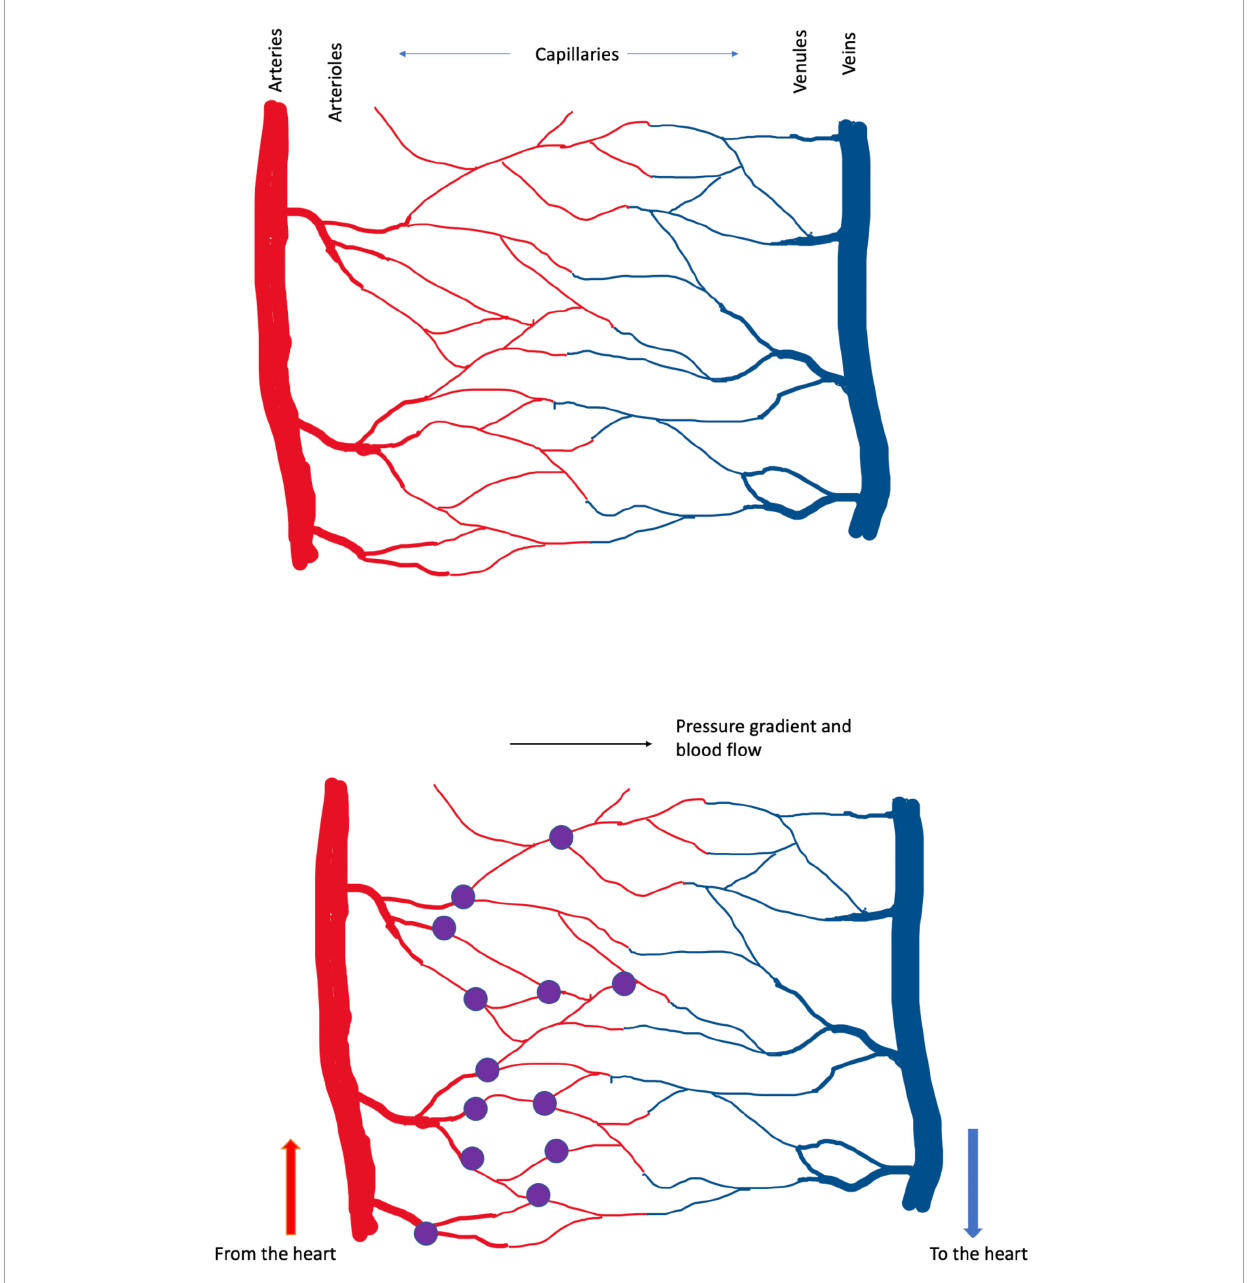
FIGURE2 (Upper) Schema of cerebral blood vessels. Blood enters the brain, and other tissues, at high, pulsatile pressure, along arteries. It is distributed by smaller arteries and arterioles, which break up into capillaries, from which oxygen diffuses into the tissue. Deoxygenated blood drains from capillaries into venules and veins, which return blood to the heart and lungs, for reoxygenation and recirculation. In these diagrams high pressure is in the arteries at left and blood flows left-to-right. The color change between arterial and venous blood is exaggerated; in real life venous blood is distinctly bluer than arterial. (Lower) The present analysis suggests that the small vessels of the brain, particularly the capillaries, are the brain’s weak point, in the face of trauma. In Alzheimer’s dementia, the pulse damages the capillaries, causing bleeding at the arterial ends of capillaries. These small bleeds (the purple dots) cause the plaque, tangle and inflammatory pathology that Alzheimer described and the neuronal death that underlies cognitive loss. In CTE, DP and TBI the shock waves generated by external trauma also damage the capillaries, tearing them from larger vessels, also generating small bleeds. Capillary damage in these latter conditions may not be confined to the arterial ends. Capillaries bleeds are small and the lesion caused by a single bleed is too small to cause symptoms. The cumulative effect of many small lesions, over time, is an insidious-onset